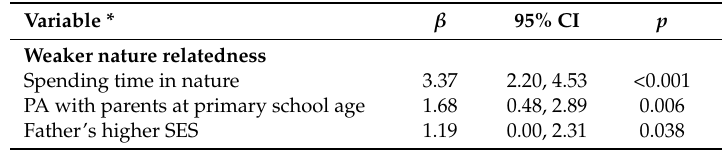
Table 3. Factors associated with nature relatedness among young men with weaker nature relatedness (NR score ≤